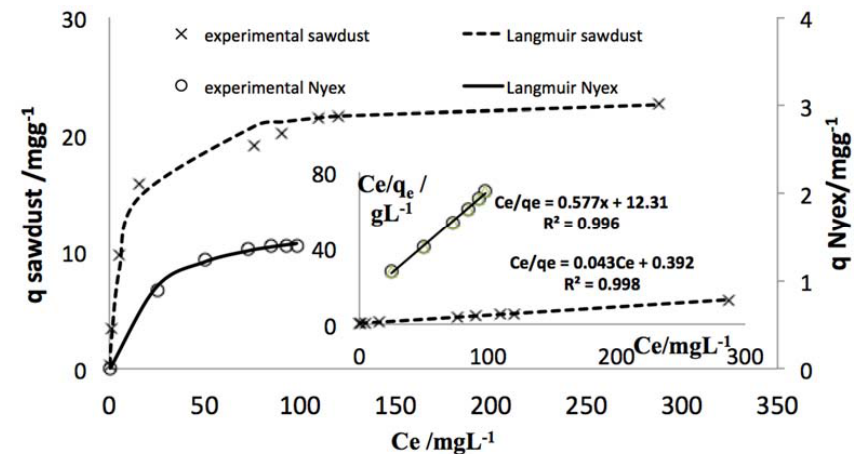
Fig. 1: Adsorption isotherms of MB onto sawdust and Nyex® at 303 K. Comparison of experimental data (symbols) with Langmuir model (lines). Inset panel: Linear form of Langmuir isotherms. Operating conditions: T=303 K. For Nyex®: C°=100 mg/L; V=100 mL; m nyex =0.5-8 g. For sawdust:m sawdust = 0.5g, V=50mL, C°=35-512 mg/L